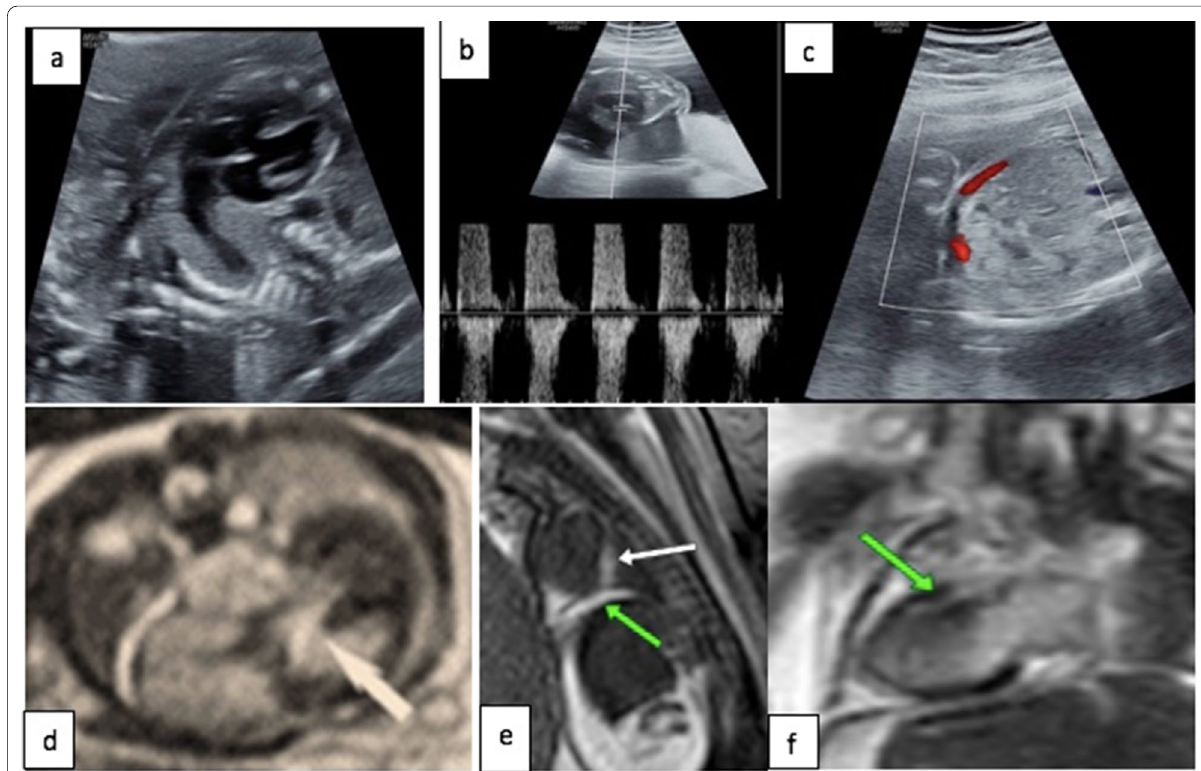
Fig. 3 20-years-old pregnant female with 25wks fetus, a , c fetal echo finding; cardiomegaly, VSD, severe tricuspid regurge and abnormal venous drainage between Umbilical vein and azygous vein noted in doppler image ( c ). d – f FCMRI finding 2 weeks later: SBFFE- 3D short dynamic axial, sagittal and coronal view shows single large inlet VSD thick white arrow in ( d ), prominent posterior azygous vein (white arrow) with compressed sub diaphragmatic umbilical vein (green arrow) draining into it in ( e ) hypoplastic pulmonary artery (green arrow in ( f ). Fetus developed sever hydrops and IUFD was